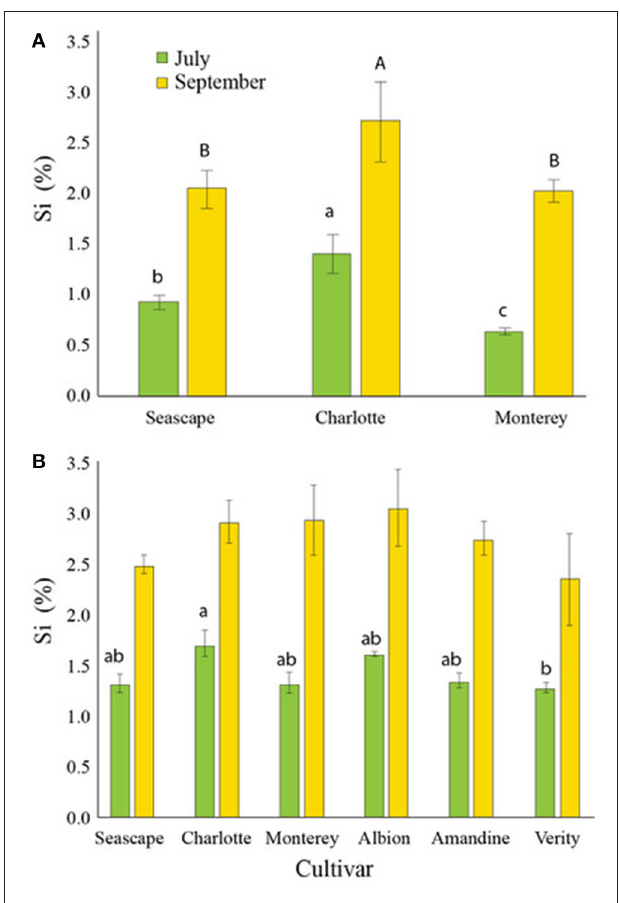
FIGURE 3 | Percent average silicon (Si) content in leaves of strawberry plants treated daily with a 1.7 mM Si solution in a high-tunnel commercial setting for two different dates in summer 2014 (A) and in summer 2015 (B) . Each value represents the mean ± SE ( n = 4). Multiple comparisons between cultivars were made each month independently. Means with different letters are significantly different (Tukey HSD).